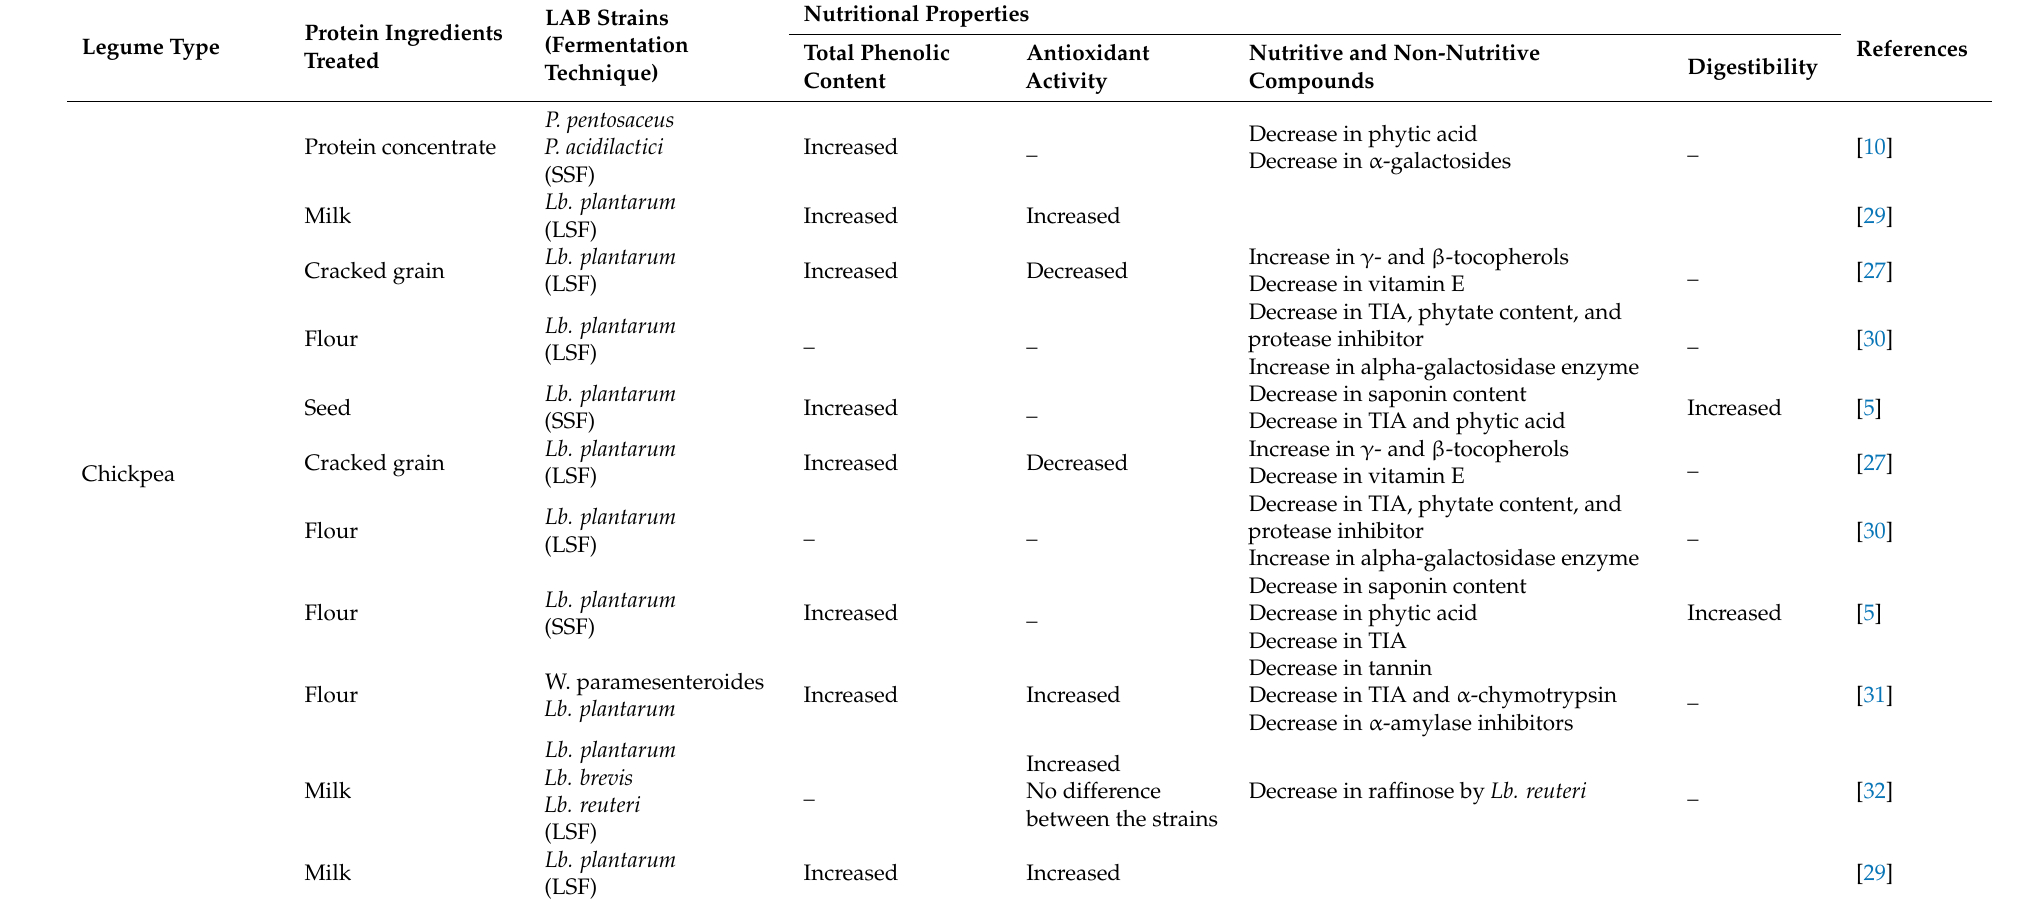
Table 1. The effects of lactic acid fermentation on nutritional properties of legume